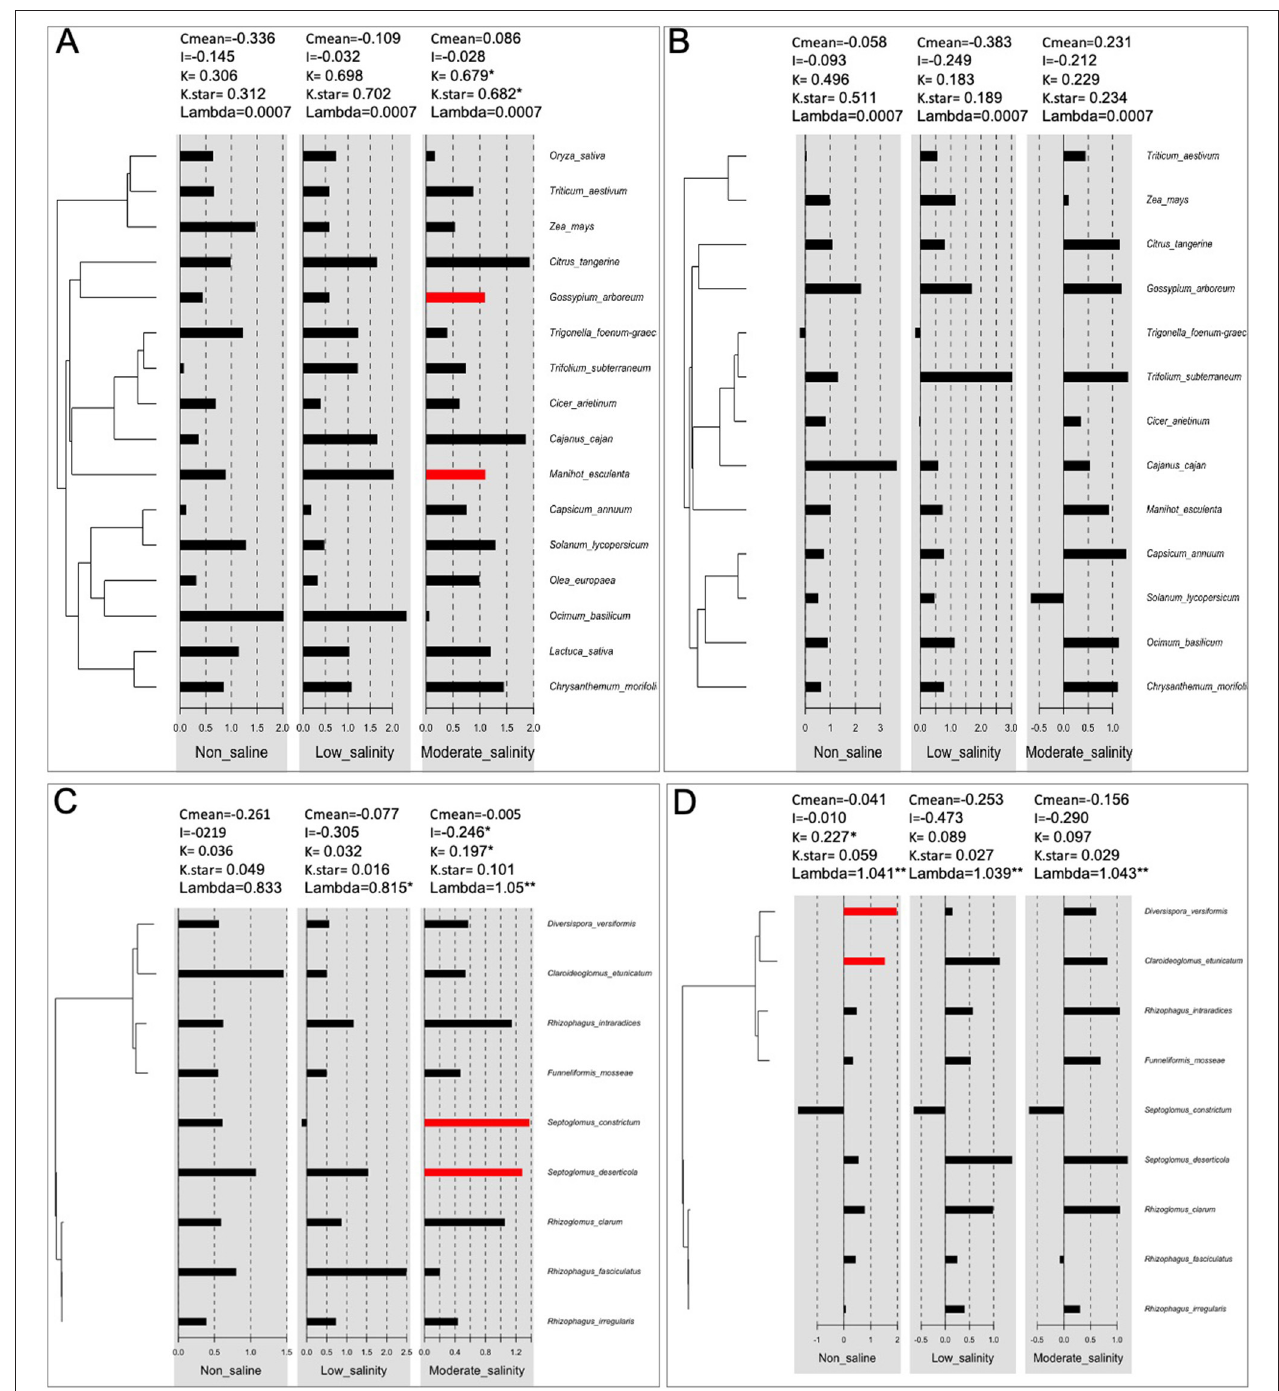
FIGURE 6 | Phylogenetic signals of plant families (A,B) and fungi (C,D) for the effects of AMF on plant shoot (A,C) and root (B,D) biomass under non-saline and salinity stress conditions. C mean, I, K, K-star, and lambda are as described in the section Materials and Methods. The red bar indicates that the signals are positive. *, **indicates that the signals are significant at p < 0.05 and p < 0.01, respectively. moderate salinity caused a higher level of proline accumulation in AMF-treated plants that was marginally higher ( p = 0.034) than that in non-AMF-treated plants ( Figure 9D ).